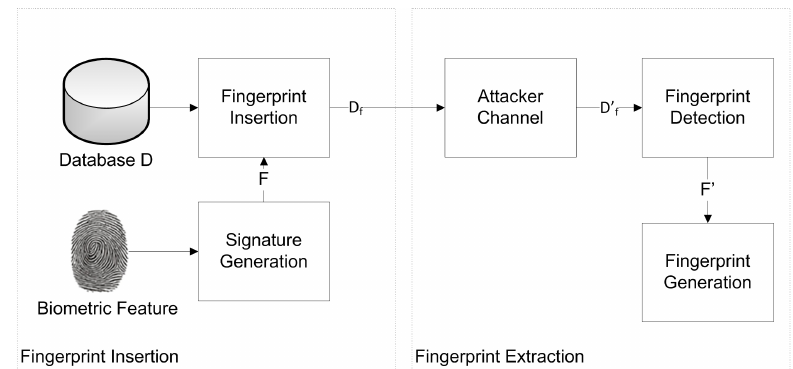
Figure 2. Overview of the proposed